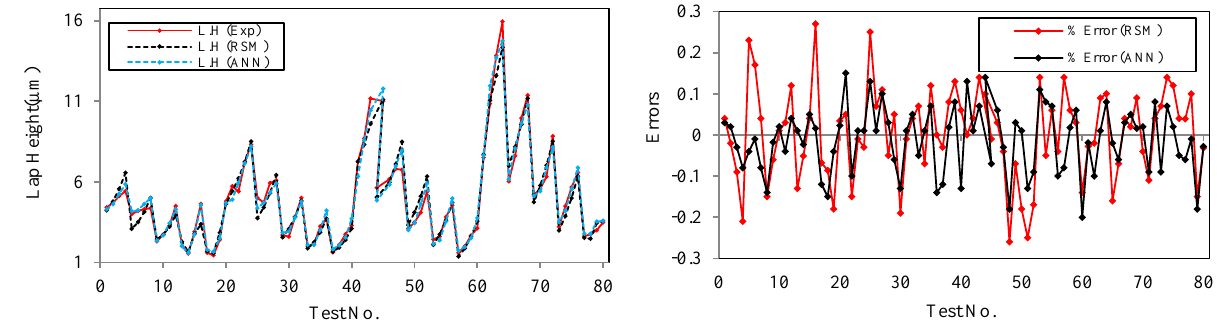
Fig. 8. L. W and % Errors comparison for the ANN and RSM